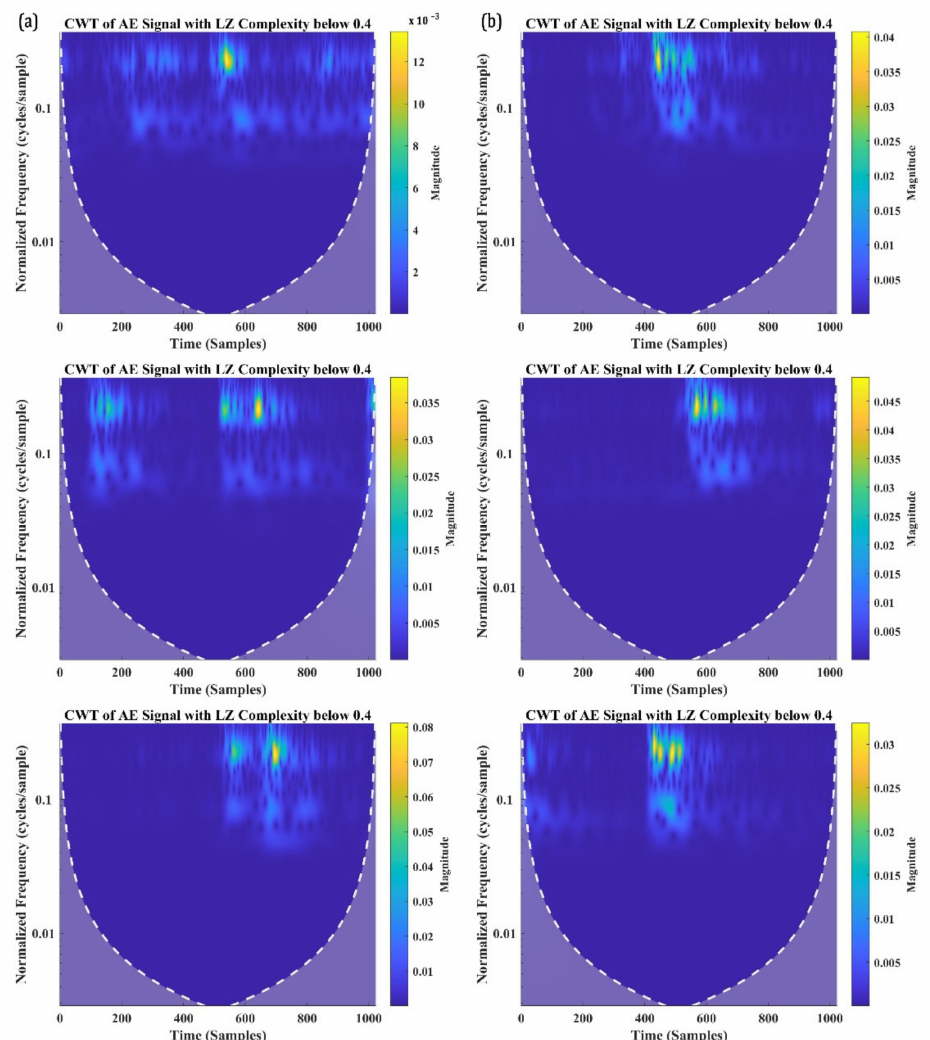
Figure 13. CWT of the AE signals with W.P-Freq above 350 kHz and LZ complexity below 0.4 recorded from SBS specimens tested at ( a ) 100 ◦ C and ( b ) 120 ◦